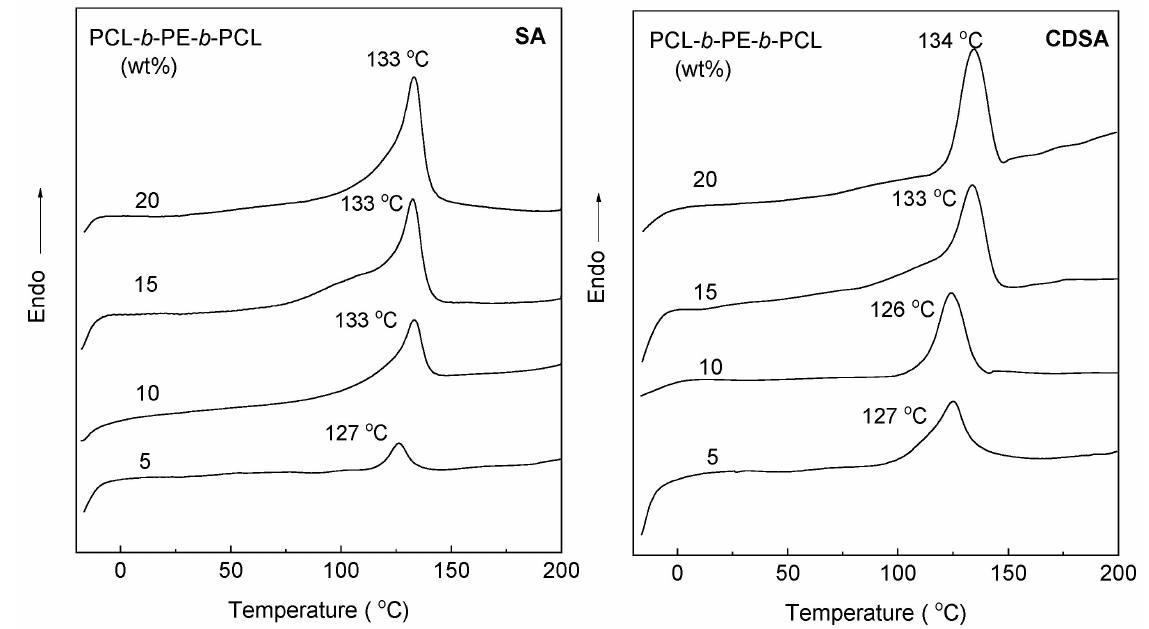
Figure 7. Heating DSC curves of the nanostructured thermosets via SA and CDSA.